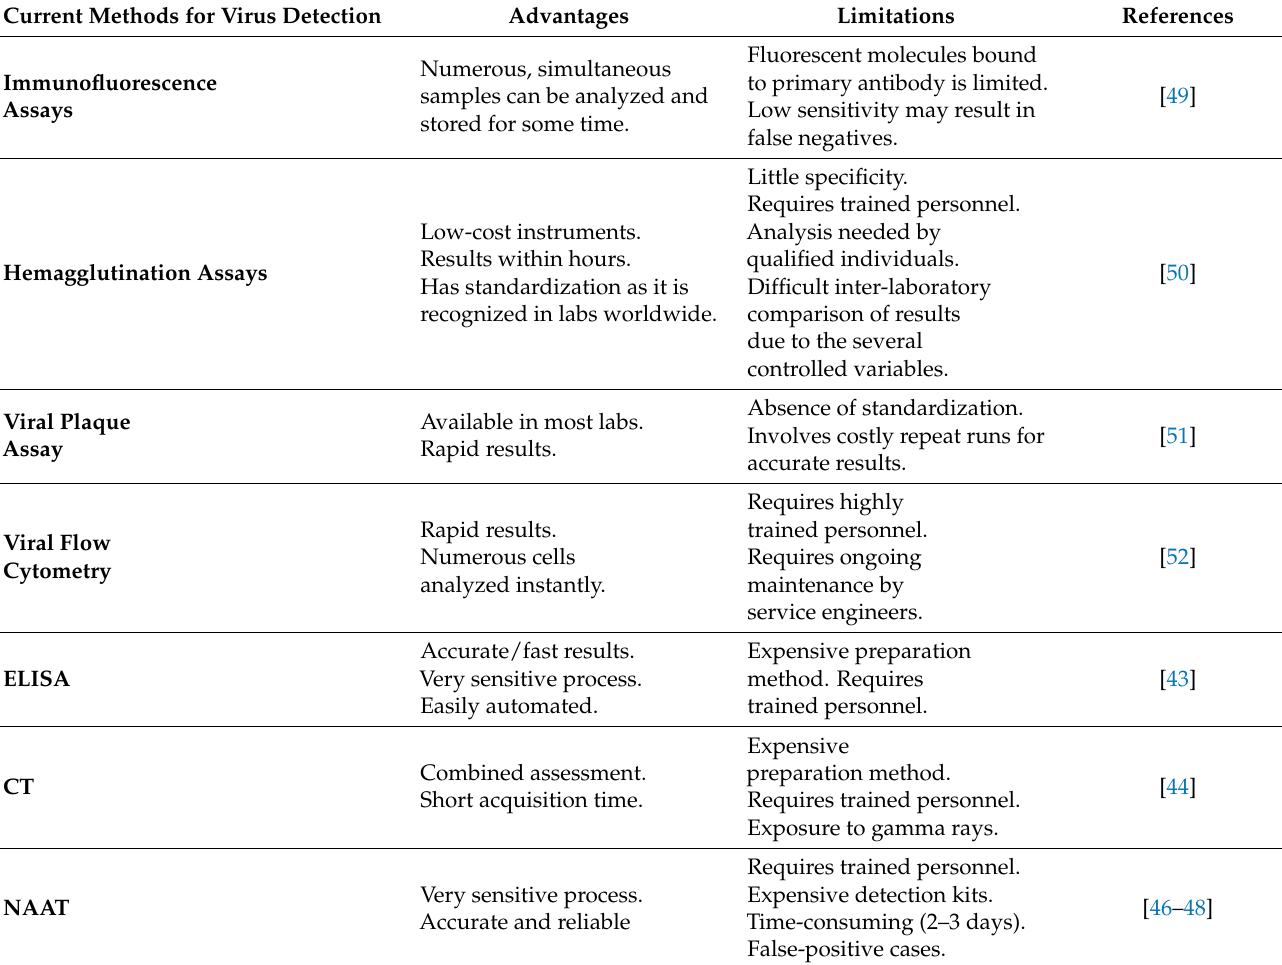
Table 1. Advantages and limitations of common viral detecting